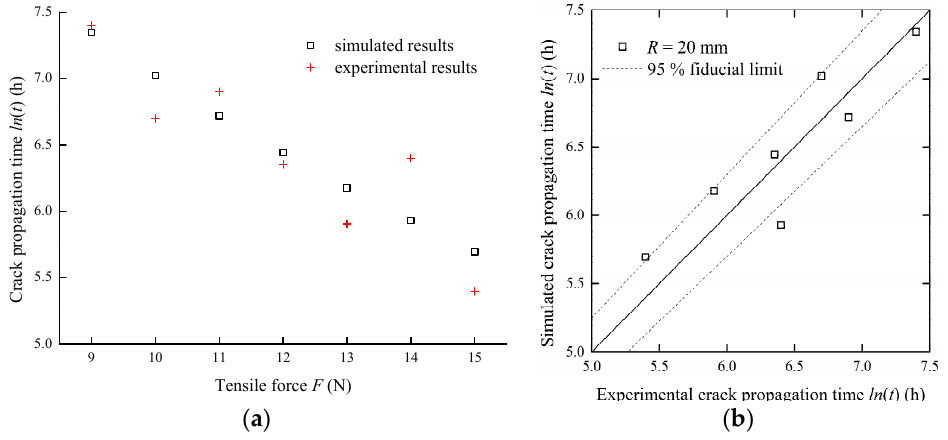
Figure 18. The comparison between the simulated and experimental crack propagation times under different tensile forces: ( a ) crack propagation time vs tensile force; ( b ) simulated results vs experimental results.